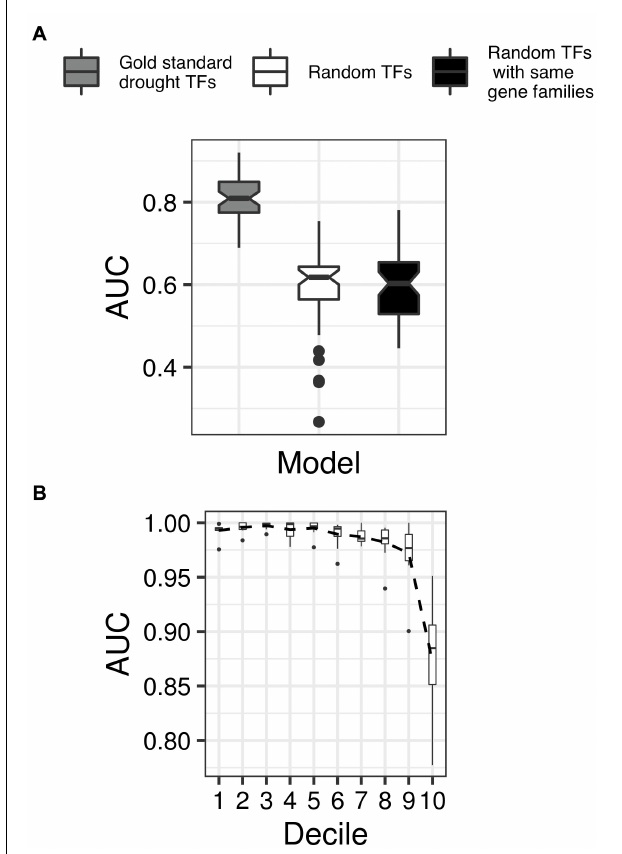
FIGURE 5 | Cross-validation of the network-based classifier. (A) Boxplots showing the distribution of the area under the precision-recall curve (AUC-PR; y-axis ) in ten independent runs of fivefold cross-validation tests of the classifier trained using gold standard drought TFs (shaded gray), the classifier trained using randomly picked TFs instead of gold standard TFs (shaded white), and the classifier trained using randomly chosen TFs but from the same families like that of the gold standard examples (shaded black). The non-overlapping notches in the boxplots indicate significant differences in the median AUC-PR for all three classifiers. (B) TFs were sorted according to their decreasing order of drought scores assigned by the final classifier and grouped into 100 equal-sized bins. Expression levels (transcript per million units) of TFs in each bin were then used as features to classify a set of labeled RNA-seq samples as drought or control (data from GSE74793). Each boxplot shows the distribution of AUC-ROC (x-axis) from threefold cross-validation tests in groups of ten bins, with lower-numbered bins ( y-axis ) indicating TFs with higher drought scores. The black dotted line connects the mean of each decile’s AUC-ROC scores, indicating decreasing AUC-ROC with lower drought